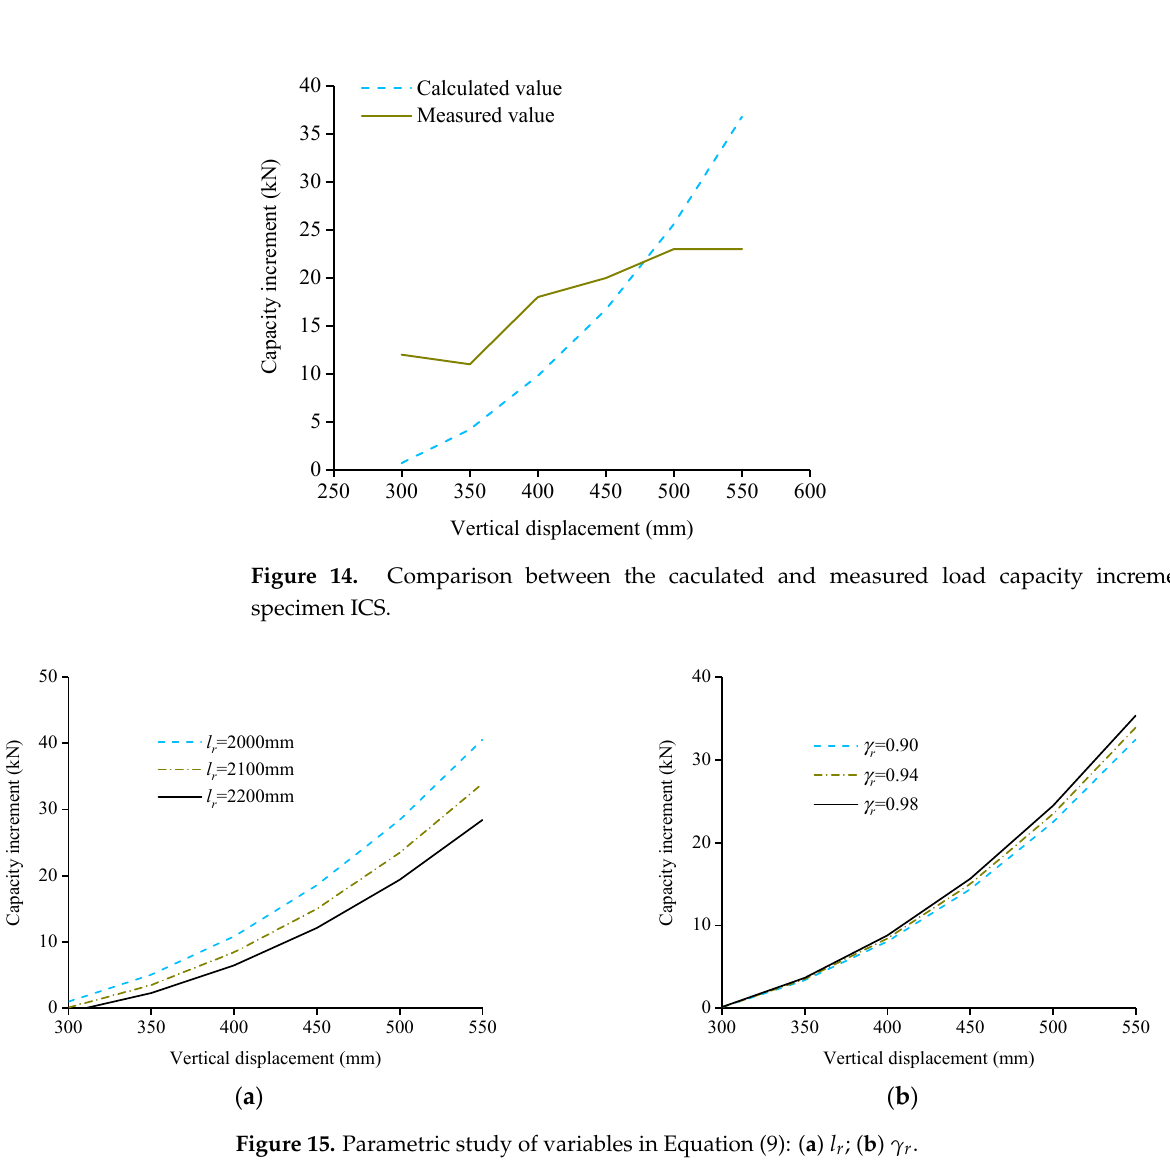
Figure 15. Parametric study of variables in Equation (9): ( a )